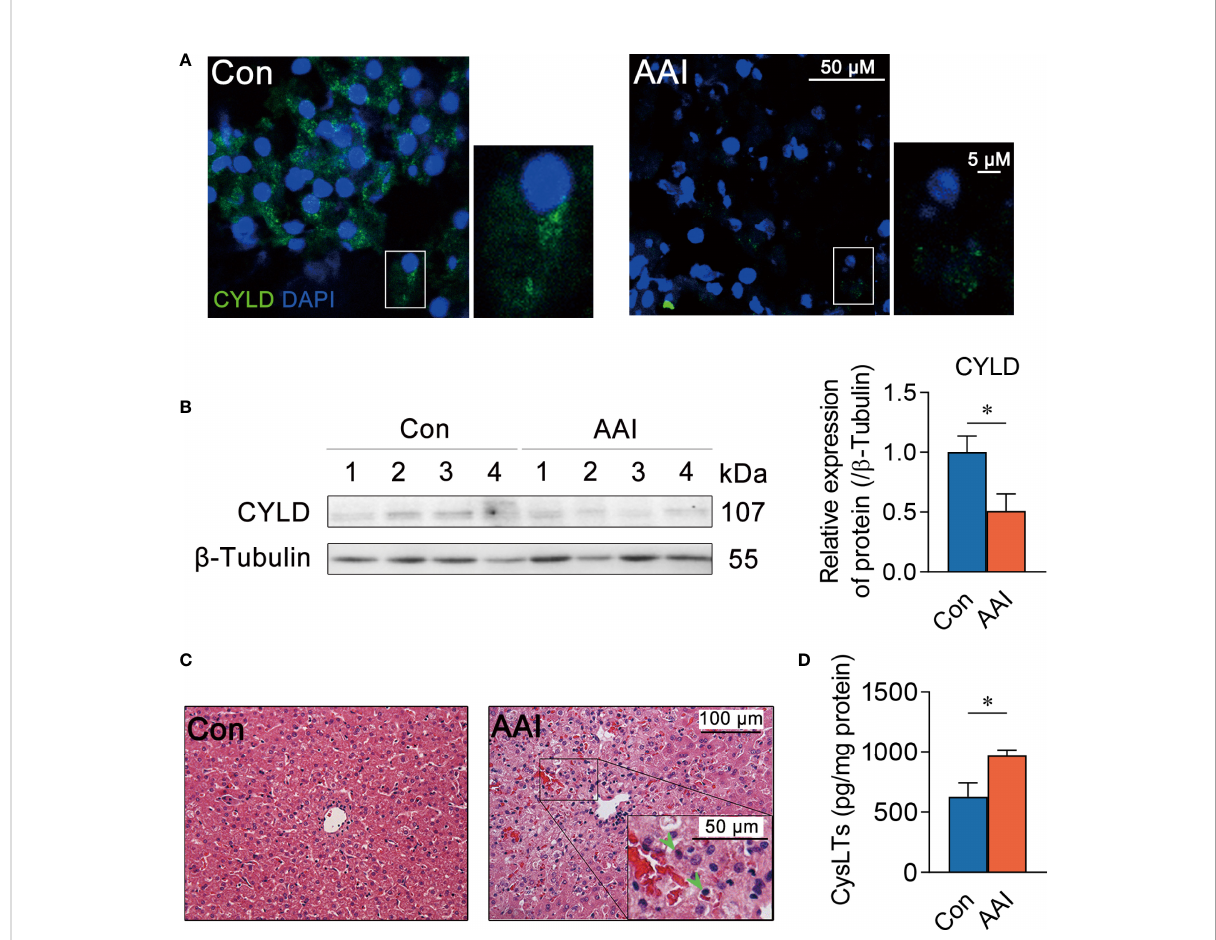
FIGURE 4 Hepatic CYLD attenuation is parallel to increased CysLTs production after AAI treatment in canines. Liver tissues were obtained from canines after treatment with AAI (3 mg/kg/day) or fi ller only (negative control, Con) for 10 days. (A) Representative photomicrographs of CYLD (green: distribution in cytoplasm, DAPI: nuclei) in liver sections stained by immuno fl uorescence histochemistry. Bar = 50 m m, bar = 5 m m (magni fi cation). (B) Immunoblot analysis of hepatic CYLD expressions. b -Tubulin was used as an internal loading control. (C) Representative photomicrographs of liver sections stained with H&E (in fl ammatory cells, arrowheads). Bar = 100 m m, bar = 50 m m (magni fi cation). (D) Supernatant CysLTs level in liver tissue homogenate detected by ELISA. Error bars represent the mean value ± SD; Student unpaired t- test was used to compare groups, and p- value less than 0.05 was considered as statistically signi fi cant. * p < 0.05 vs. control. For each analysis, n = 4/per